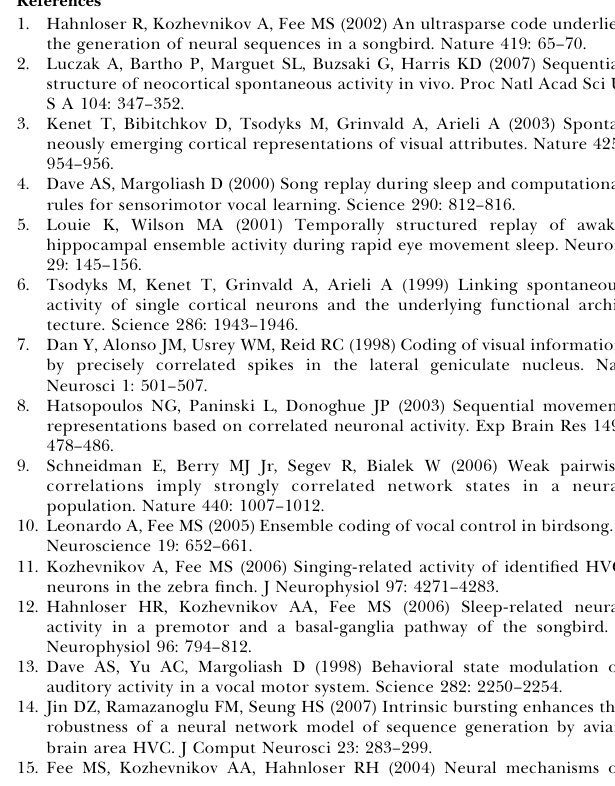
Figure S3. Average CSP Functions Fitted without Burst